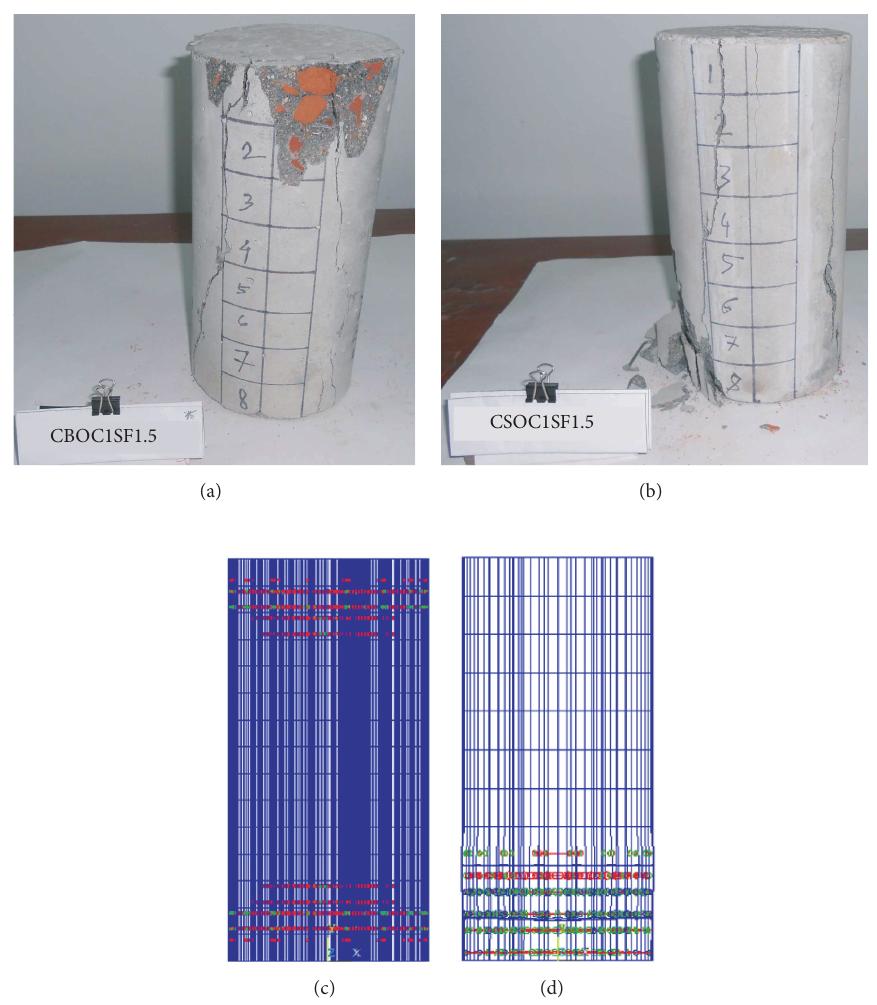
Figure 11: Failure patterns of compression specimens, (a) brick SFRC, (b) brick SFRC, and ((c) and (d)) failure pattern of FE